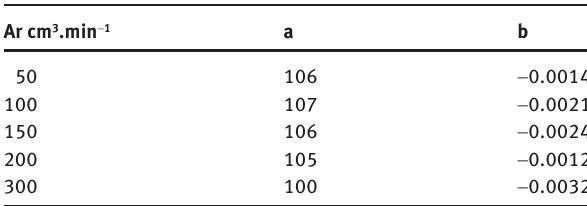
Table 5: Values of the a and b parameters (Equation 1) for the exponential lines of best fit to the flow rate series of transport experiments.